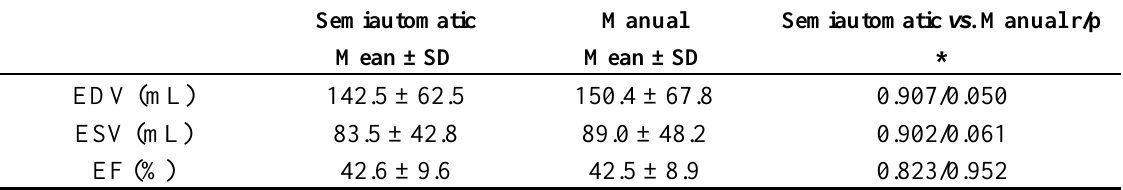
Table 2. Quantification of right ventricular parameters using semiautomatic and manual segmentation methods.